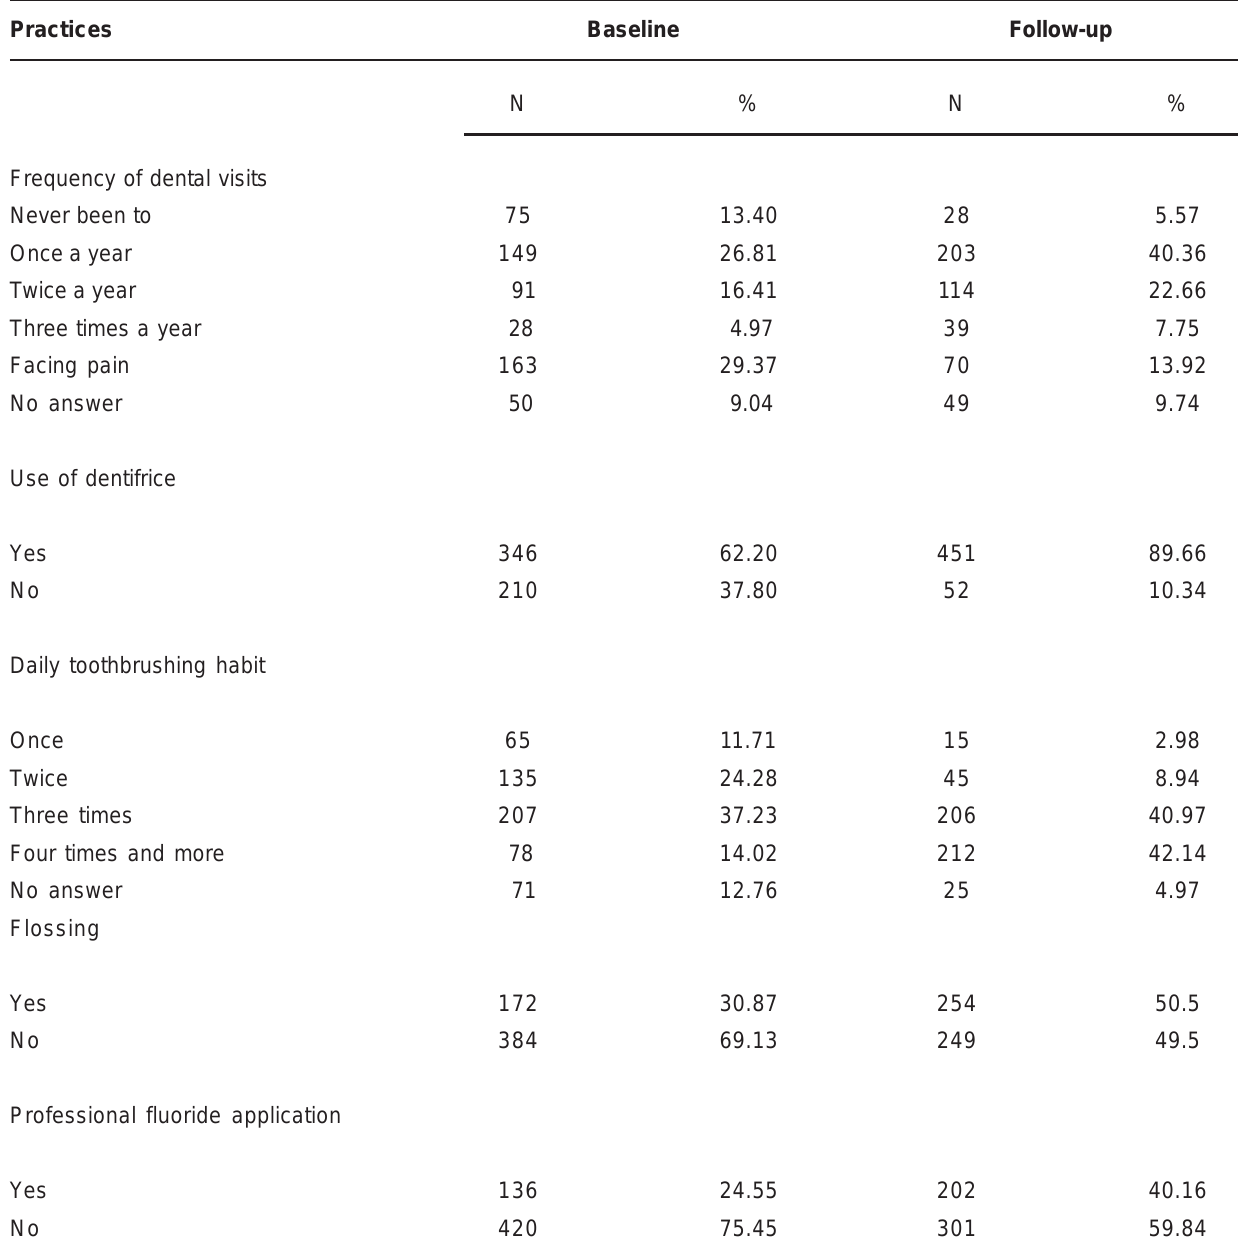
TABLE 1 - Oral health practices among children and adolescents of public schools in Maringa, Brazil, at baseline (N=556) and at follow-up interviews